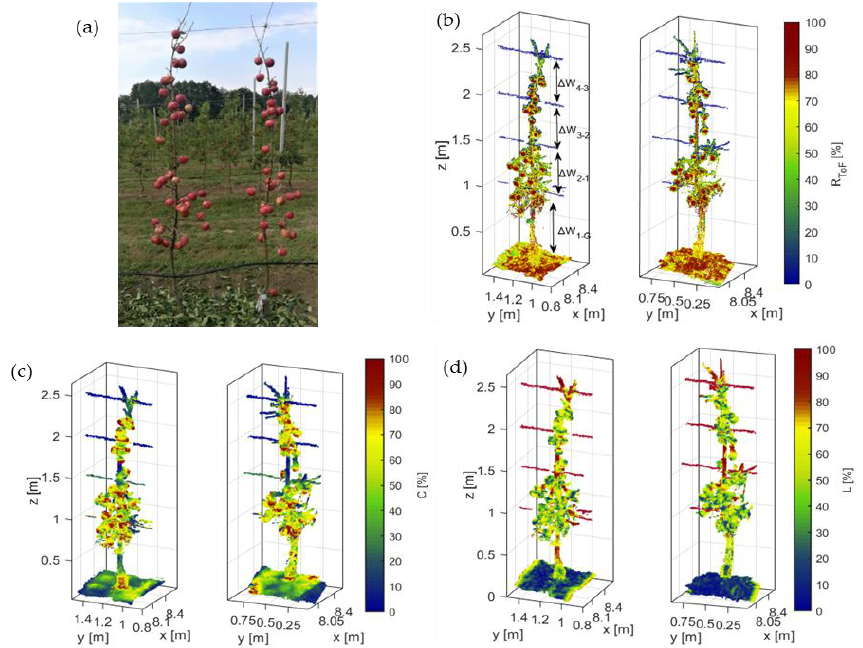
Figure 4. Representation of 3D point clouds of ( a ) RGB image ( b ) reflectance (R ToF ) [%], ( c ) curvature ( C ) [%] and ( d ) linearity ( L ) [%] in defoliated trees at DAFB 120 .